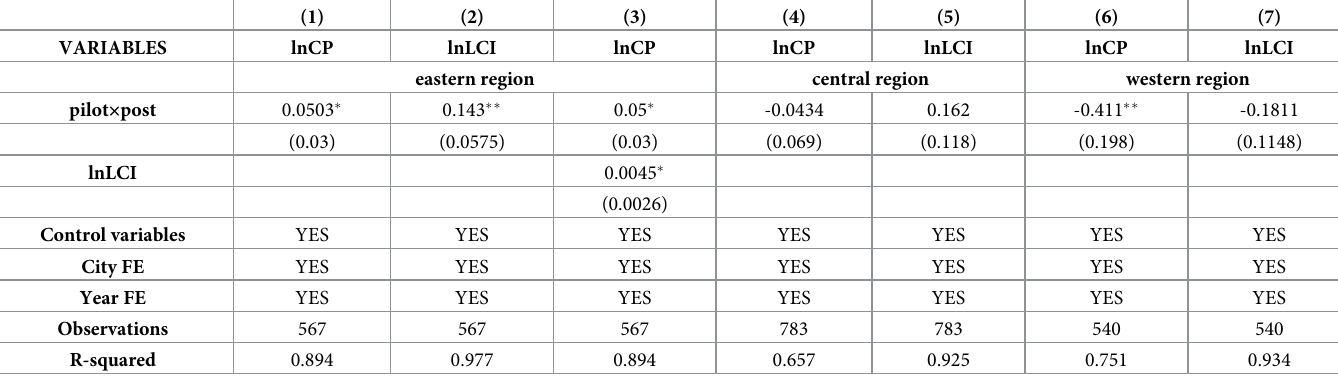
Table 5. Regional influence